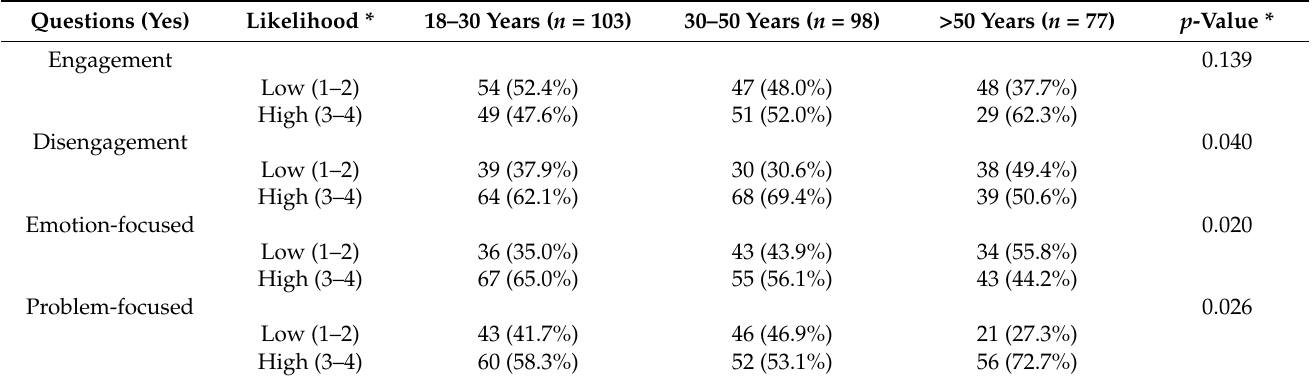
Table 3. Comparison of COPE-60 questionnaire results by age group.